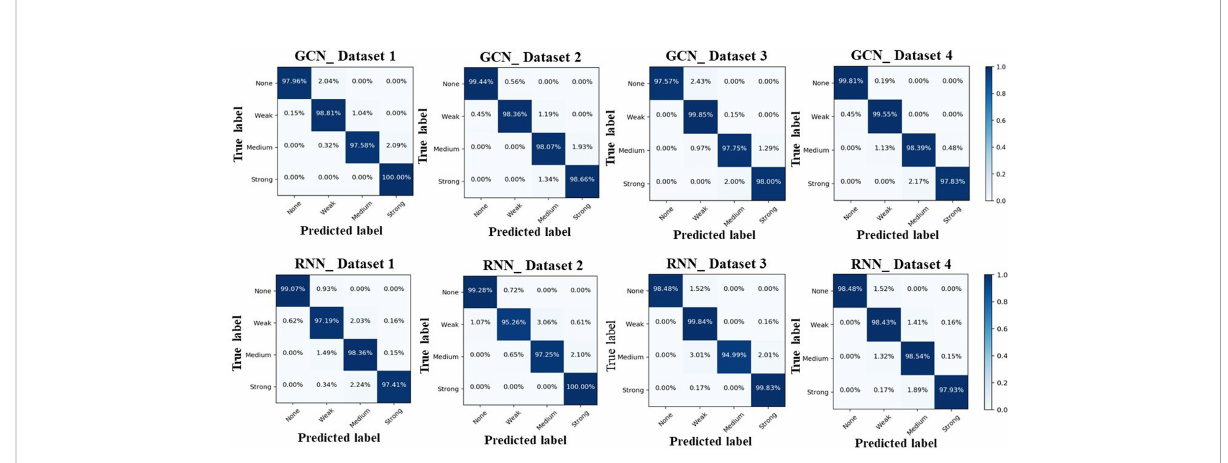
FIGURE 10 Confusion matrixes of fi sh appetite grading results of GNN-based and RNN-based methods on different datasets.